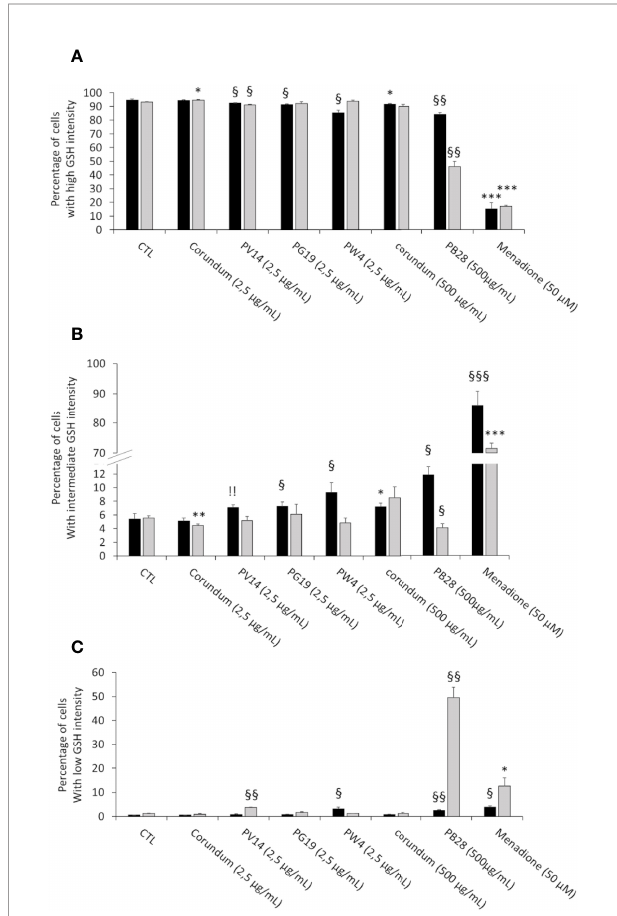
FIGURE 5 | Intracellular glutathione measurement. Black bars: acute exposure (24 hours). Grey bars: exposure for 24 hours followed by a 3-day post-exposure recovery period. Panel (A) - Percentage of cells with high intensity glutathione. Panel (B) - Percentage of cells with intermediate intensity glutathione. Panel (C) - Percentage of cells with low intensity glutathione. Menadione is used as positive control. Signi fi cance of symbols: *: different from negative control only; §: different from both negative and corundum controls 500 µg/ml. !: different from corundum control only. Number of symbols: 1: p<0.05; 2: p<0.01; 3: